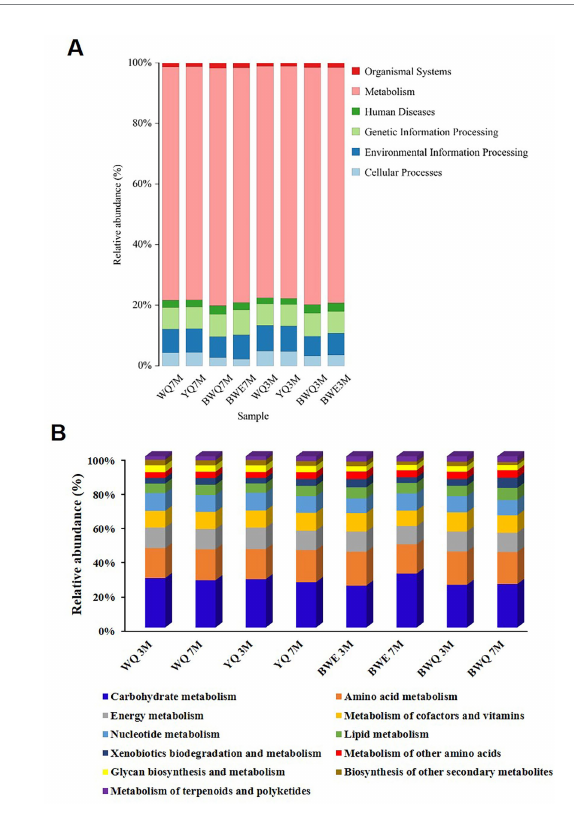
FIGURE 2 (A) Relative abundance of KEGG pathway (at level 1) in different fish sauces. (B) Relative abundance of KEGG metabolic pathways (level 2) in different fish